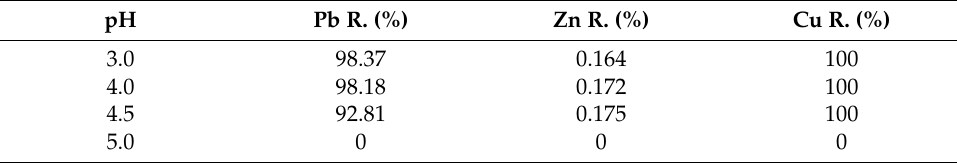
Table 3. Effect of Na 2 S after adding ammonia (R. = Rate of impurities